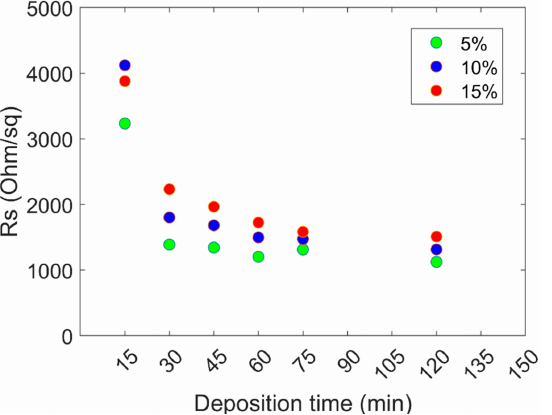
Figure 3. Sheet resistance data of the samples of the 15% (red), 10% (blue) and 5% (green) sample series.